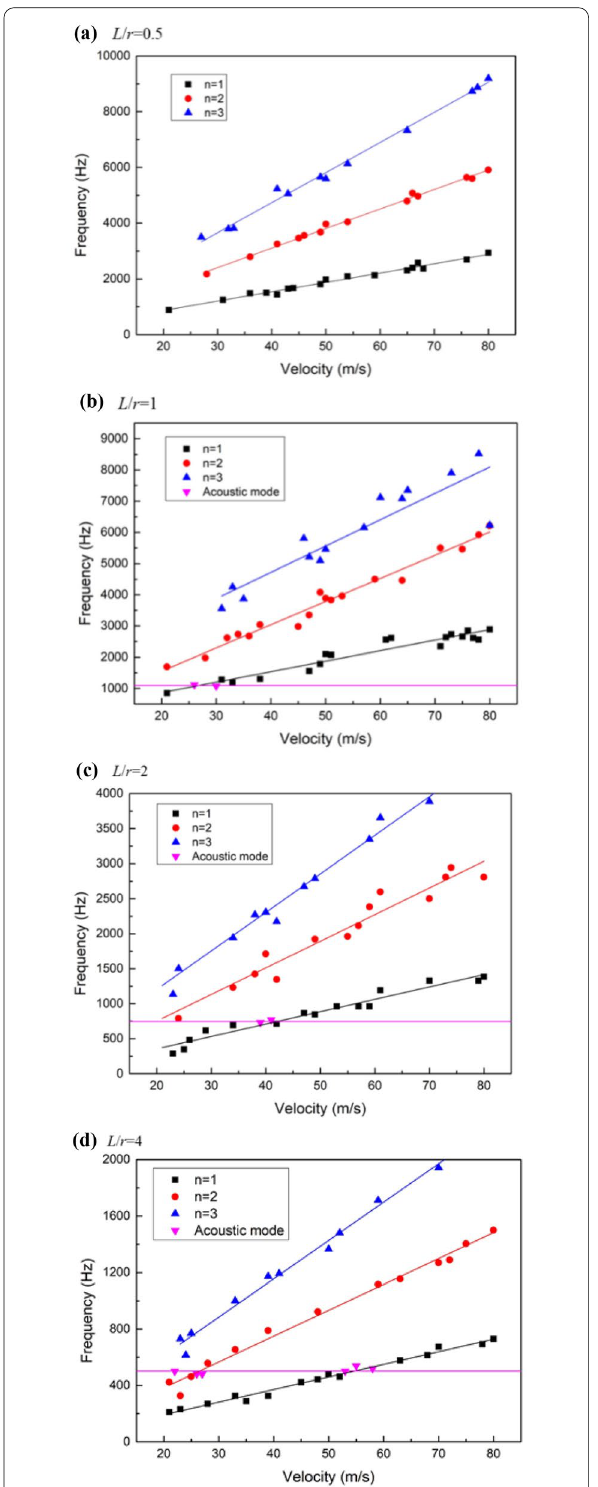
Figure 5 Frequency of cavity pressure oscillation as a function of free stream